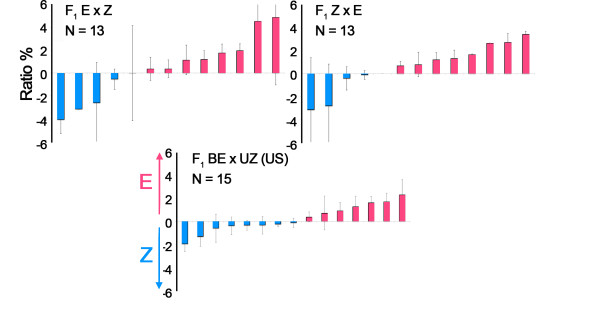
Average single sensillum amplitude ratios for individuals in each O. nubilalis F1 hybrid cross. Individuals from European (top) and American (bottom) origin crosses are arranged from lowest to highest average ratio for each group as in Figure 2.